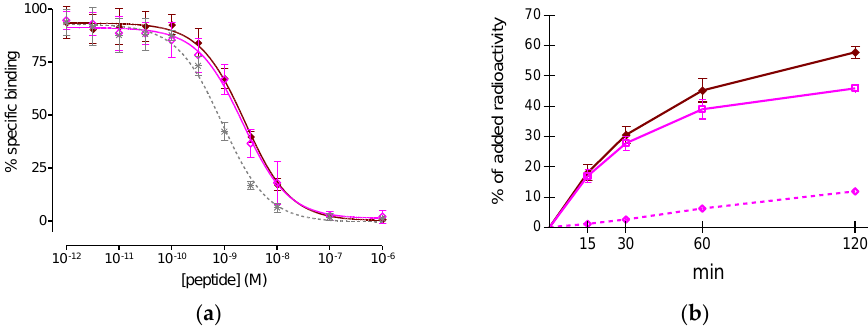
Figure 2. ( a ) [ 125 I-Tyr 4 ]BBN displacement curves from GRPR-sites on T-47D cells after 3 h incubation at 4 °C by [ nat Ga]NeoBOMB1 (IC 50 2.5 ± 0.2 nM, n = 3), NeoBOMB1 (IC 50 2.2 ± 0.2 nM, n = 3) and [Tyr 4 ]BBN (IC 50 1.33 ± 0.09 nM, n = 5); ( b ) Curves of time-dependent association of [ 67 Ga]NeoBOMB1 to T-47D cells at 37 °C. Results represent average specific cell binding ± sd ( MB+I: membrane bound + internalized) vs. total added activity for each time point ( n = 3, in triplicate); non-specific values were retrieved in the presence of 1 μ M NeoBOMB1 and were subtracted from totals; the study was conducted with T-47D cells at 80–85% confluency.